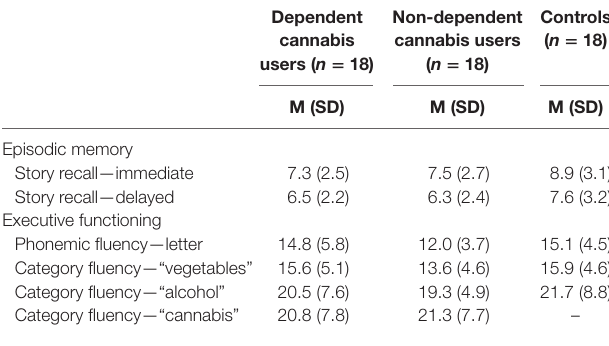
Table 3 | Episodic memory and executive functioning in dependent cannabis, non-dependent cannabis, and control